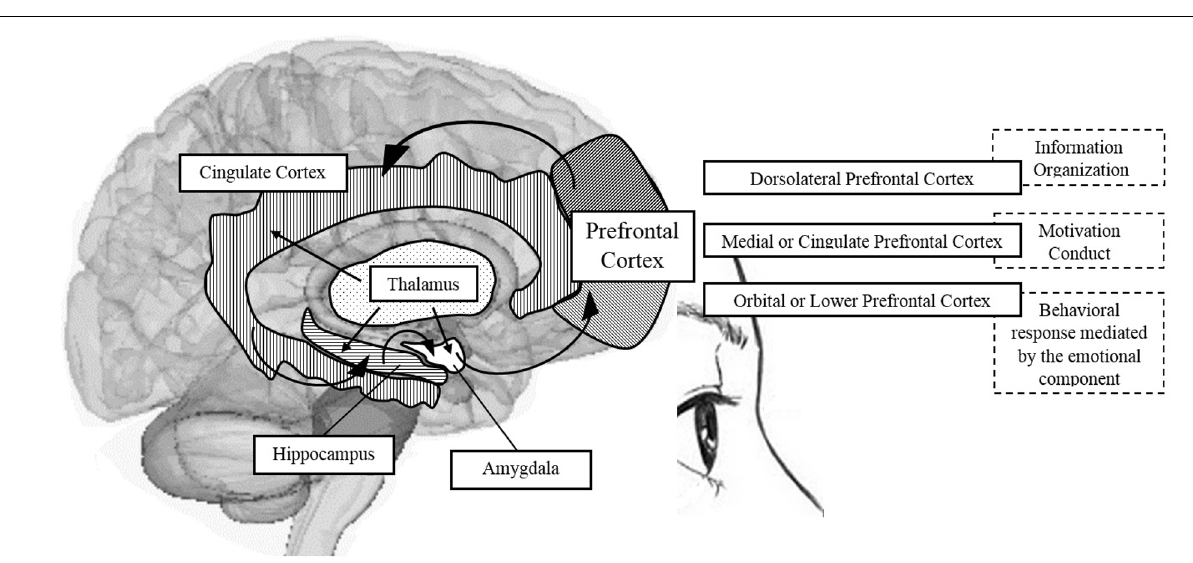
FIGURE 2 | Schematic representation of brain areas associated with the PFC and participation in shaping some components of EFs. Source: made by